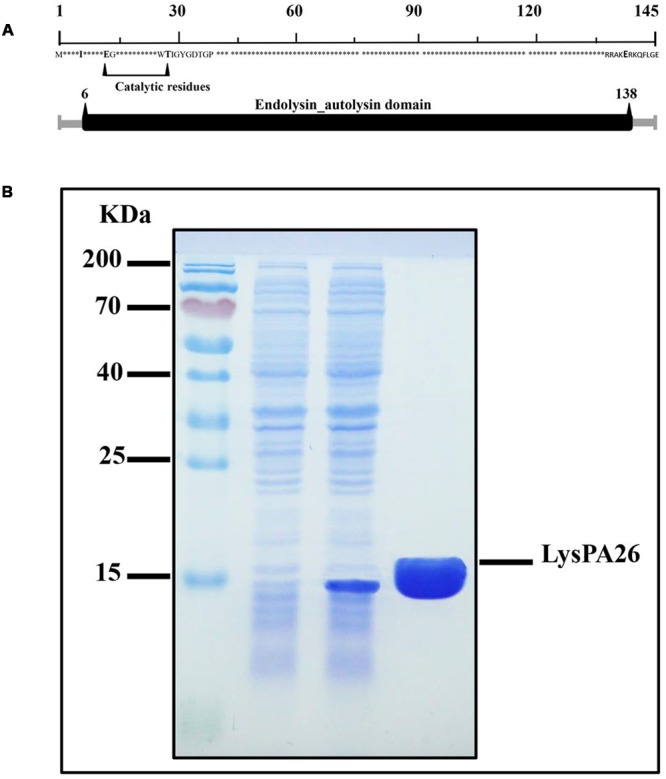
Expression and characterization of LysPA26. (A) Schematic diagram of the domain organization of LysPA26. The predicted lysozyme-like domain is marked in dark gray, and involves amino acids 6–138. (B) SDS-PAGE gel (15%) of samples from the purification process of LysPA26. Lane 1, molecular size ladder; lane 2, crude lysate extract of BL21(DE3) before induction; lane 3, crude lysate from isopropyl-β-D-thiogalactopyranoside-induced bacteria; lane 4, the purified LysPA26 (21 kDa).